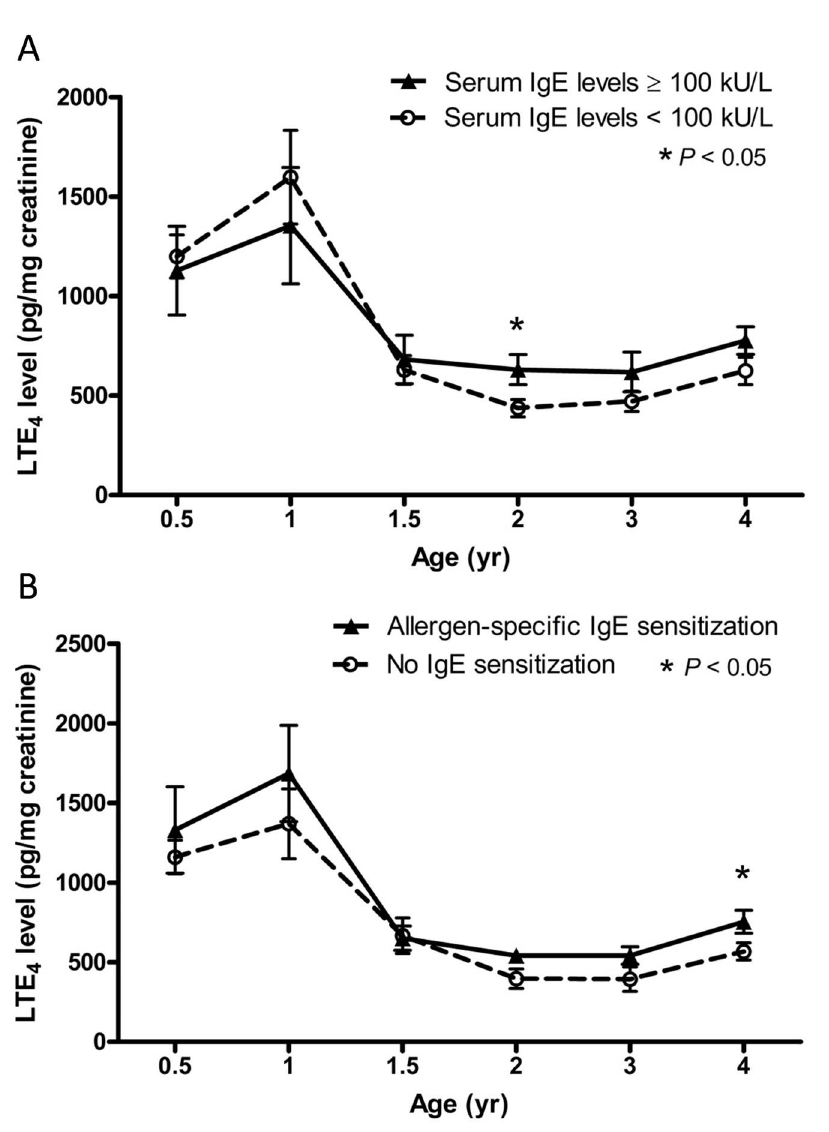
Fig. 3. Levels of urinary LTE 4 levels categorized by high serum IgE levels (A) and allergen-specific IgE sensitization (B) at different years of age. Data shown are mean ¡ SEM. * P , 0.05 as compared to children without IgE